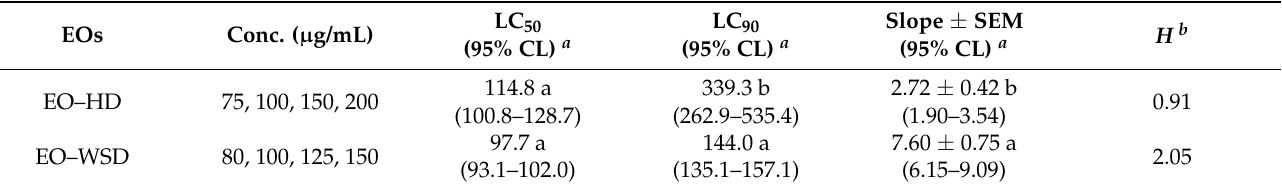
Table 1. Estimated values of lethal concentration of 50 and 90 (LC 50 and LC 90 ) of essential oils (EOs) of Azorean Cryptomeria japonica leaf obtained by two distillation techniques against Artemia salina nauplii after 24 h of exposure.